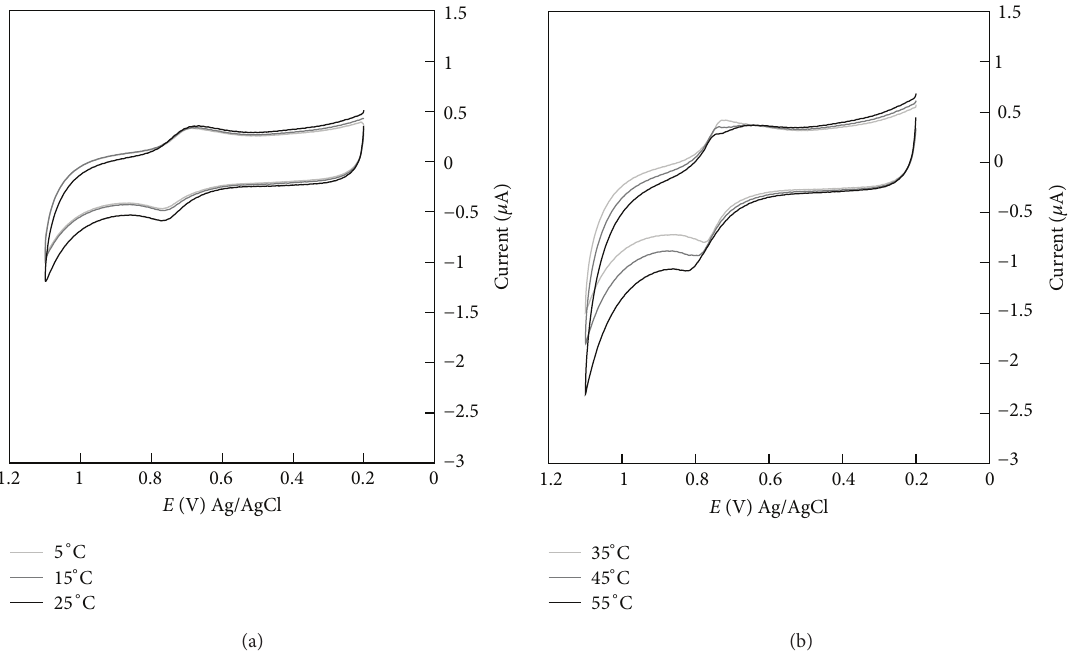
Figure 7: Cyclic voltammograms of PNIPAAm- block -PTEMPOMA- block -PNIPAAm ( 3 󸀠 ) in 0.1 M KCl aqueous solution at (a) 5, 15, and 25 ∘ C, (b) 35, 45, and 55 ∘